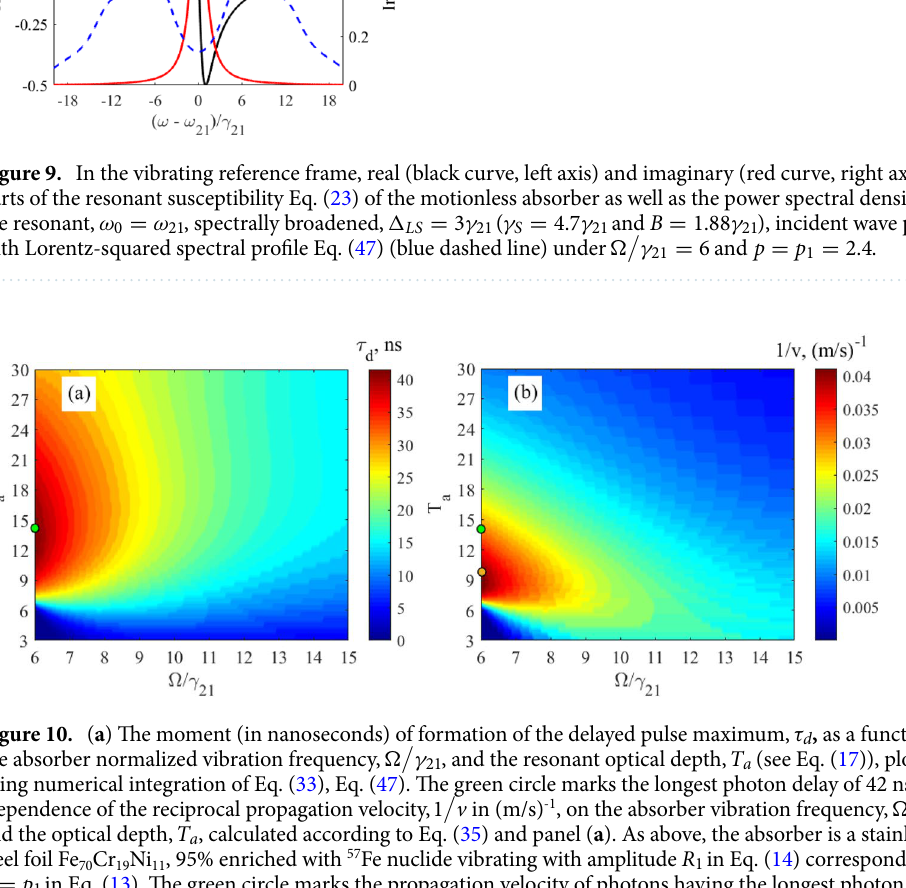
Figure 10. ( a ) The moment (in nanoseconds) of formation of the delayed pulse maximum, τ d , as a function of γ 21 , and the resonant optical depth, T a (see Eq. (17)), plotted the absorber normalized vibration frequency, � using numerical integration of Eq. (33), Eq. (47). The green circle marks the longest photon delay of 42 ns. ( b ) (cid:31) γ 21 , v in (m/s) -1 , on the absorber vibration frequency, � Dependence of the reciprocal propagation velocity, 1 and the optical depth, T a , calculated according to Eq. (35) and panel ( a ). As above, the absorber is a stainless- (cid:31) (cid:31) steel foil Fe 70 Cr 19 Ni 11 , 95% enriched with 57 Fe nuclide vibrating with amplitude R 1 in Eq. (14) corresponding to p p 1 in Eq. (13). The green circle marks the propagation velocity of photons having the longest photon delay, = which corresponds to the red waveform in Fig. 11 and equals 30 m/s. The orange circle marks the minimum propagation velocity of Lorentz-squared photons equal to 24